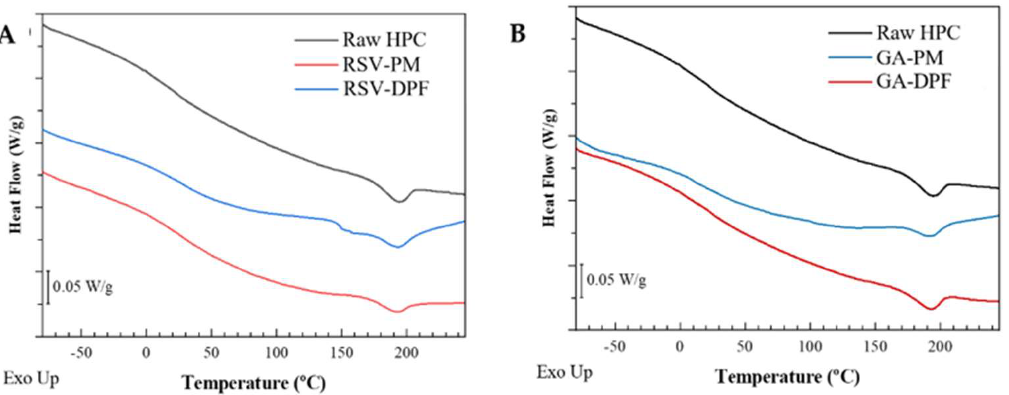
Figure 6. DSC thermograms (Run 2) for ( A ) RSV–DPF and ( B ) GA–DPF; PM: physical mixture.